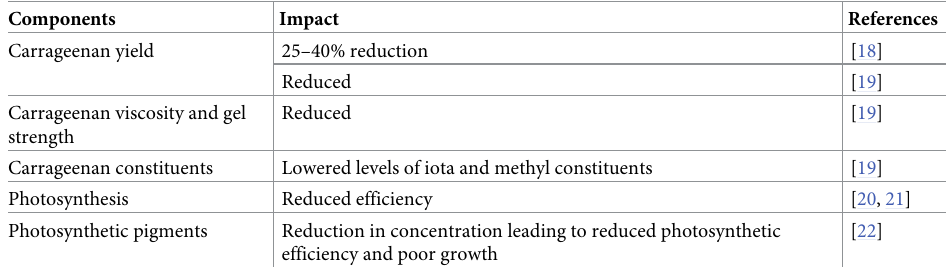
Table 1. Reported impact of ice-ice on K . alvarezii